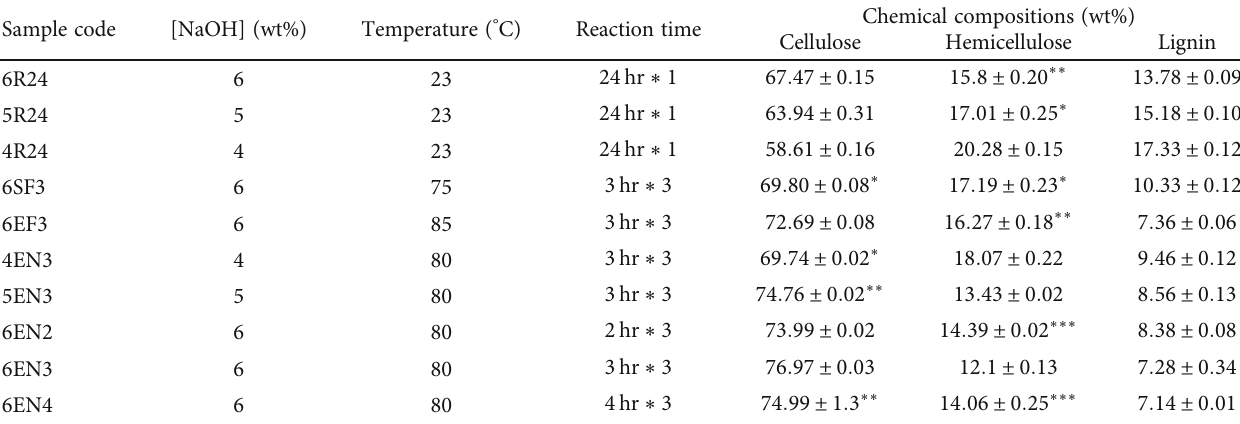
Figure 4: Optical microscope image of untreated (ROA), dewaxed (DOA), and alkali-treated (AOA) Oxytenanthera abyssinica fi ber. Table 2: The evaluation of the relationships between NaOH concentration, reaction time, and temperature with lignin, hemicellulose, and cellulose content after alkaline